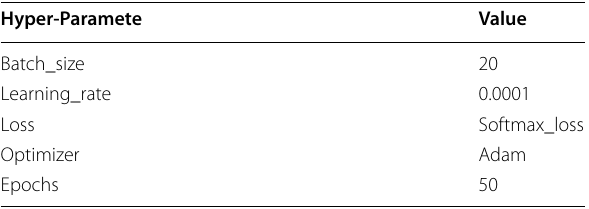
Table 3 Optimal hyperparameter setting